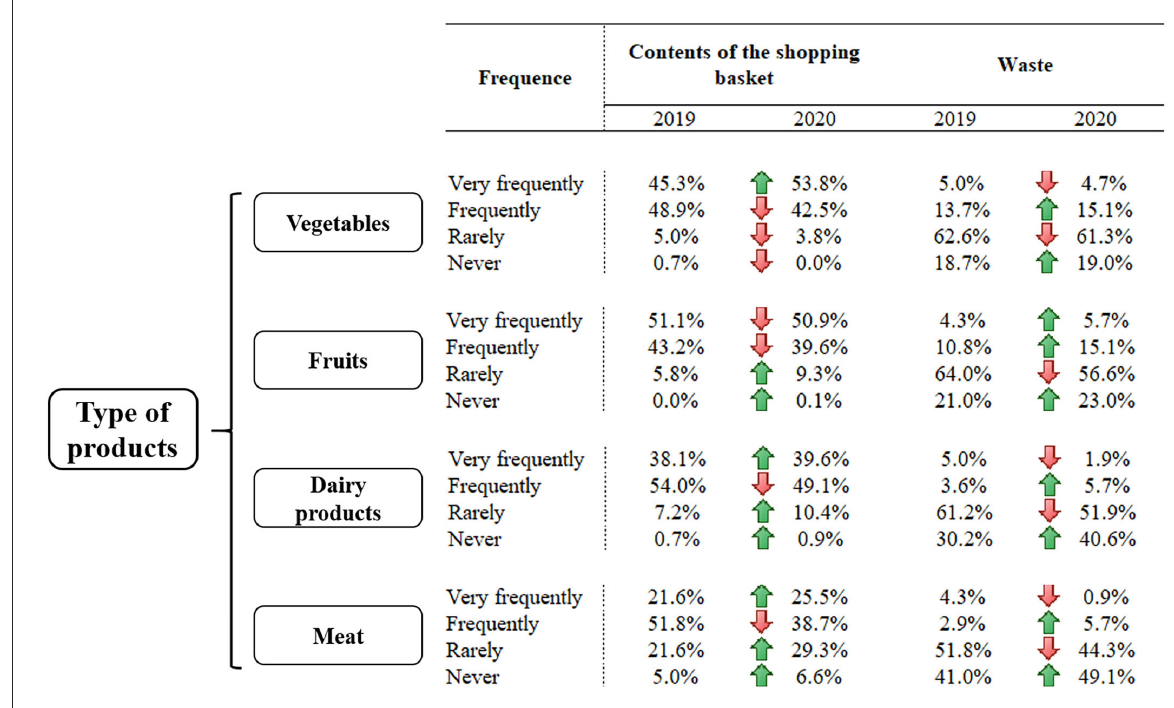
FIGURE3 Shopping patterns in terms of the contents of the shopping basket and